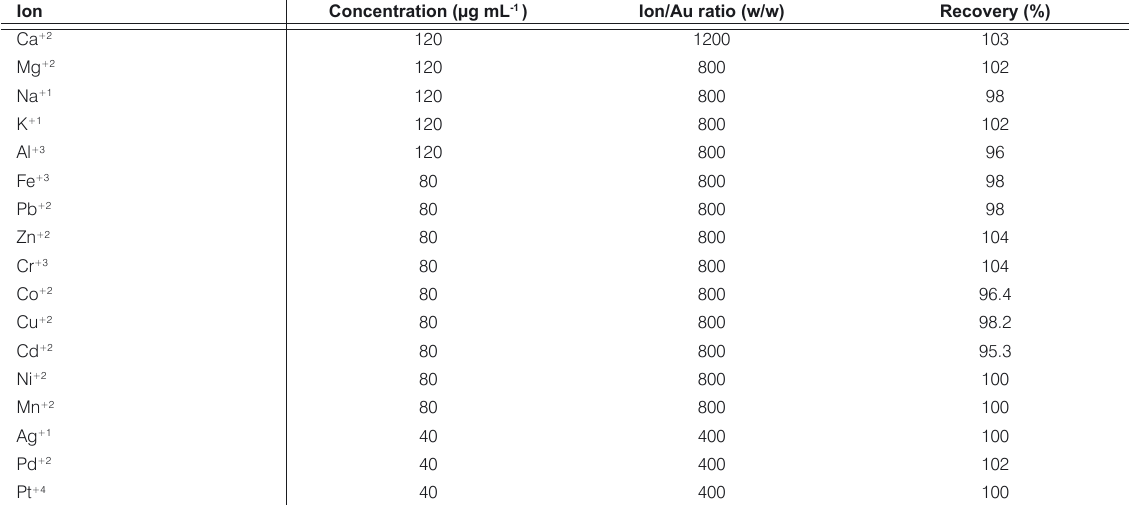
Table 2. Effects of the foreign on the recovery of 100 ng mL -1 of Au from aqueous solutions